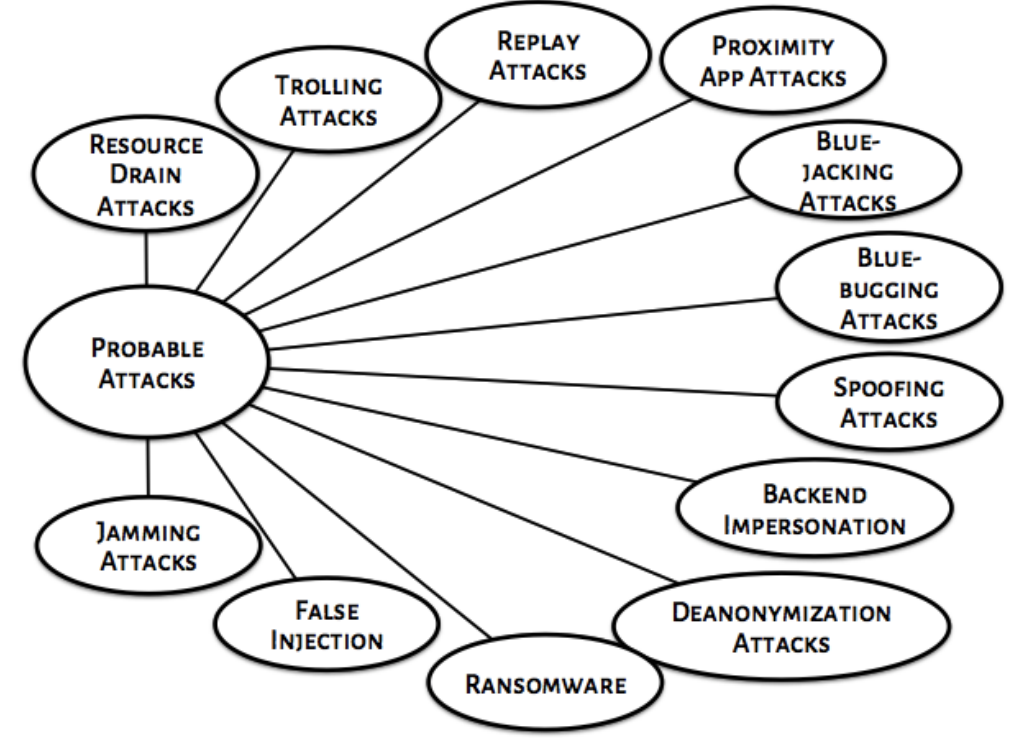
Figure 3. Probable attacks on contact tracing